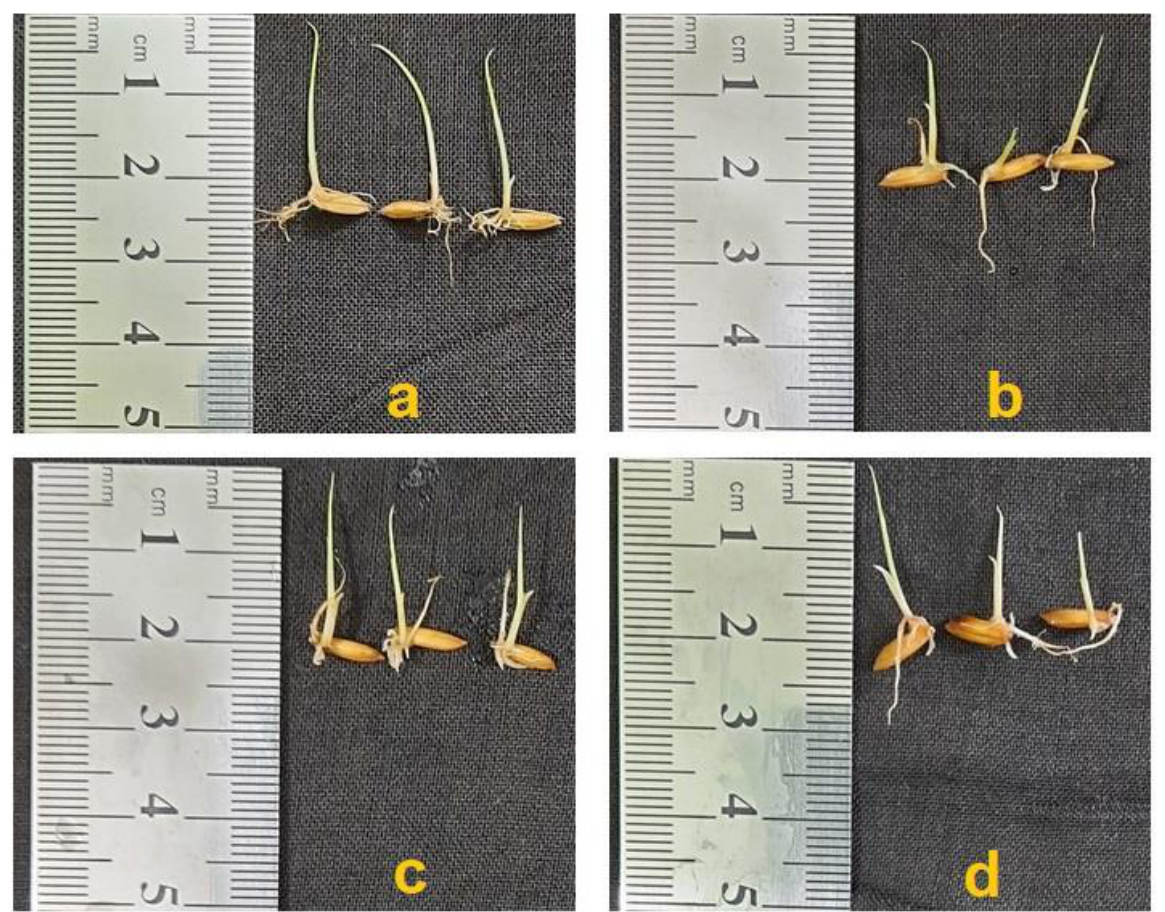
Figure 4. Assessment of BRRI dhan29 rice seedlings treated with three bacterial isolates at 1% salinity. ( a ) Control; ( b ) BTCoSo2; ( c ) BTCoR2, and ( d ) IBGE3C.